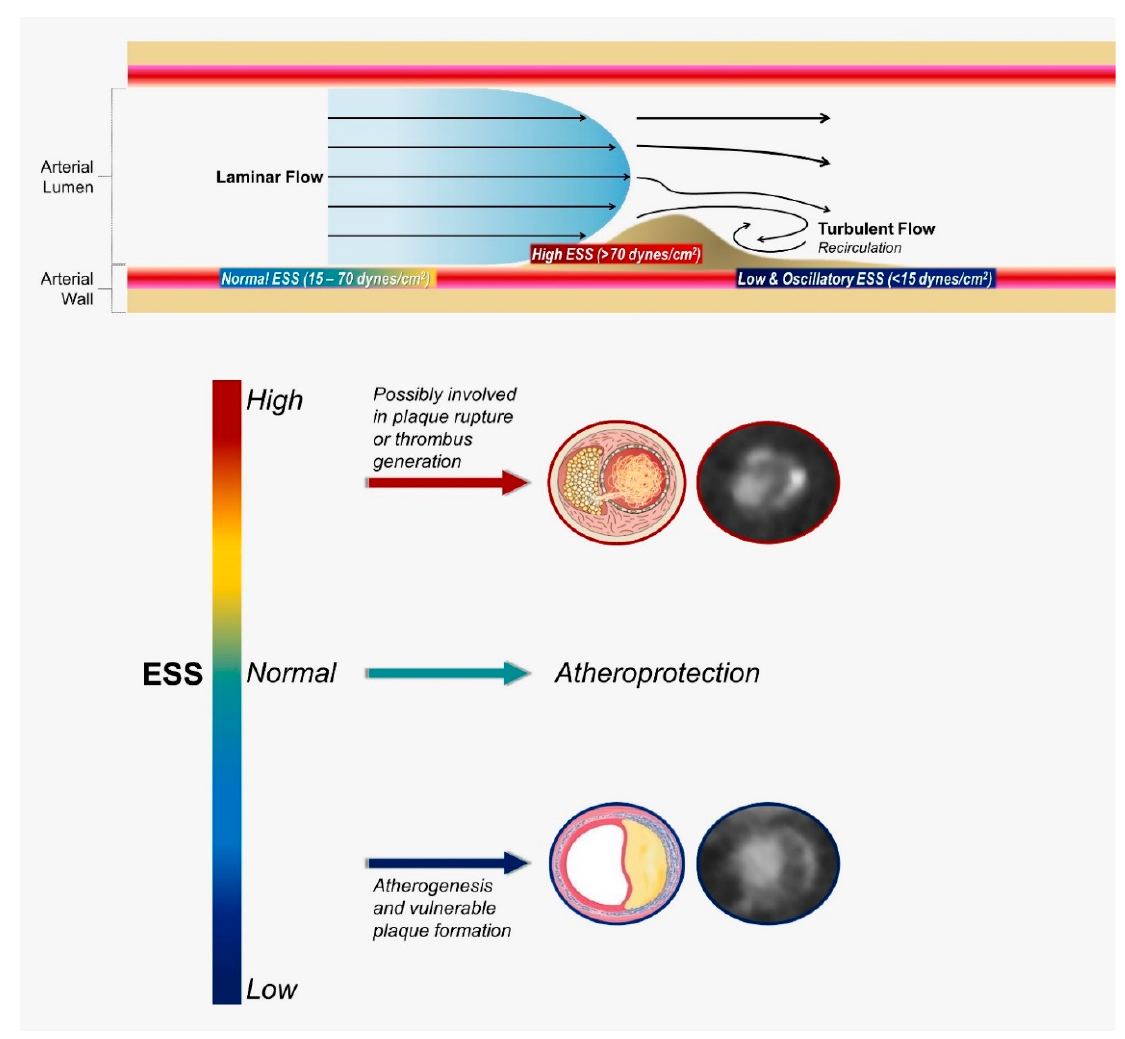
Figure 1. Blood flow patterns, levels of shear stress, and their effects on atherosclerosis. ESS, endothelial shear stress.